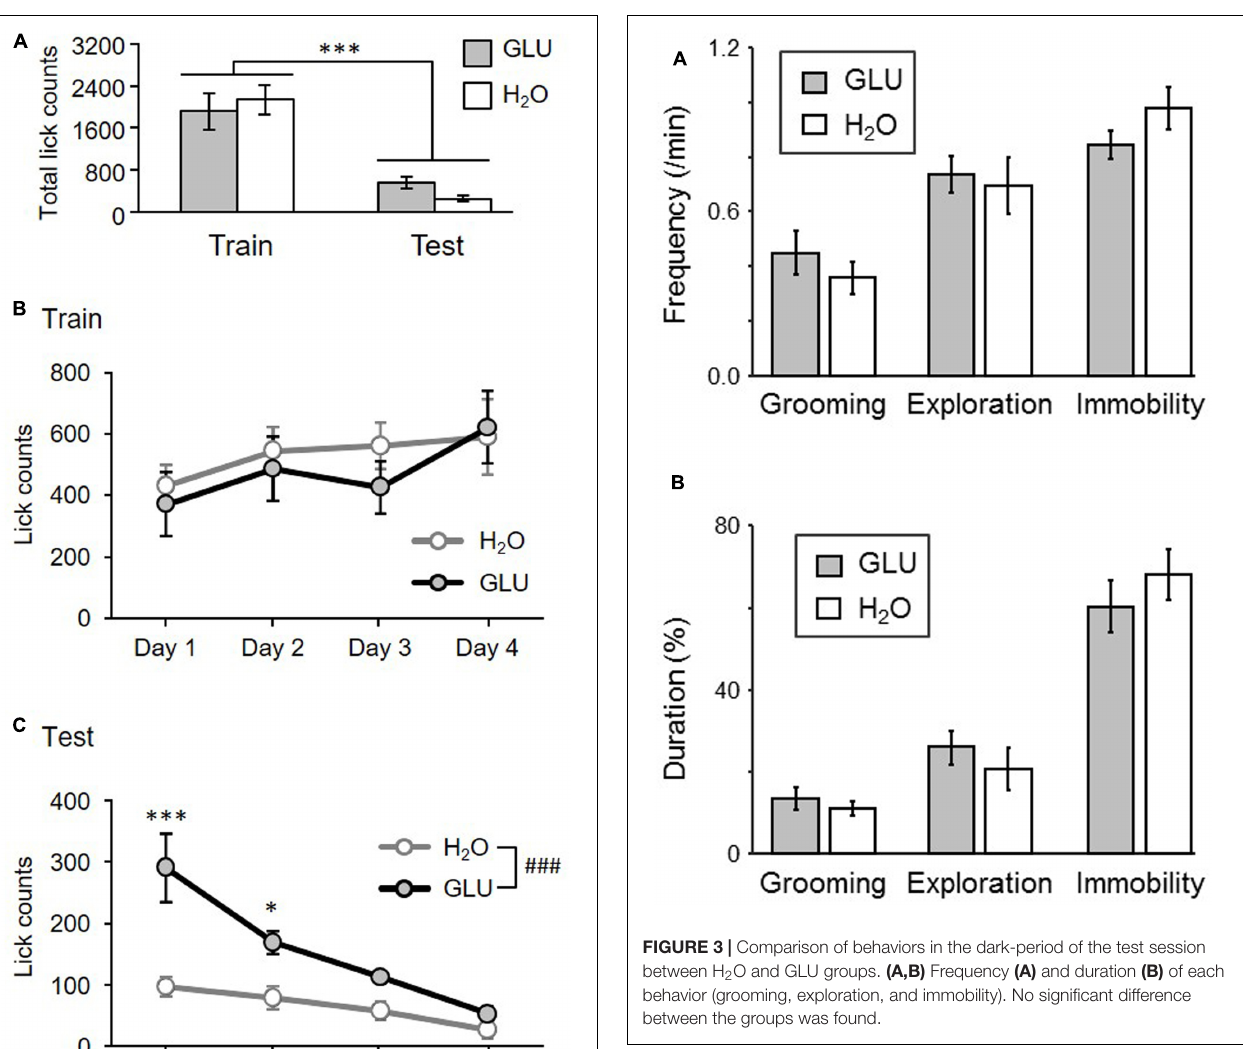
p = 4.5 × 10 − 6 ). There was no significant main effect of